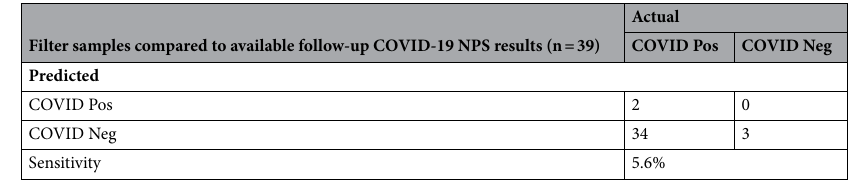
Table 4. Diagnostic performance of face mask filters compared to follow-up NPS for SARS-CoV-2 detection by qRT-PCR. Filter samples compared to follow-up COVID-19 NPS result.